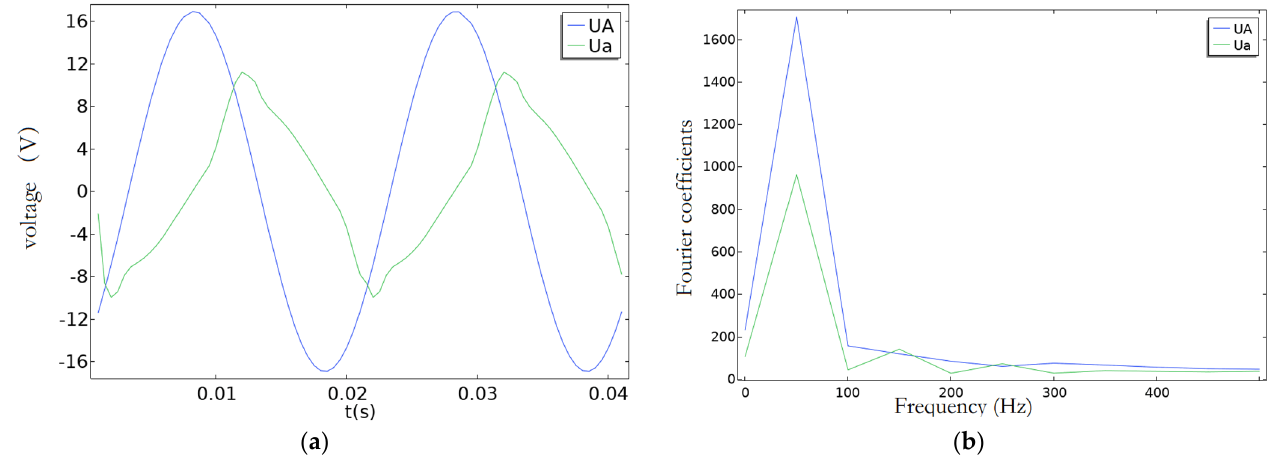
Figure 11. Magnetic-flux-induced voltage simulation waveform. ( a ) The phase-flux-induced voltage U A of column A and the flux-induced voltage U a of frame a with zero-sequence flux path; ( b ) the frequency spectrum diagram.